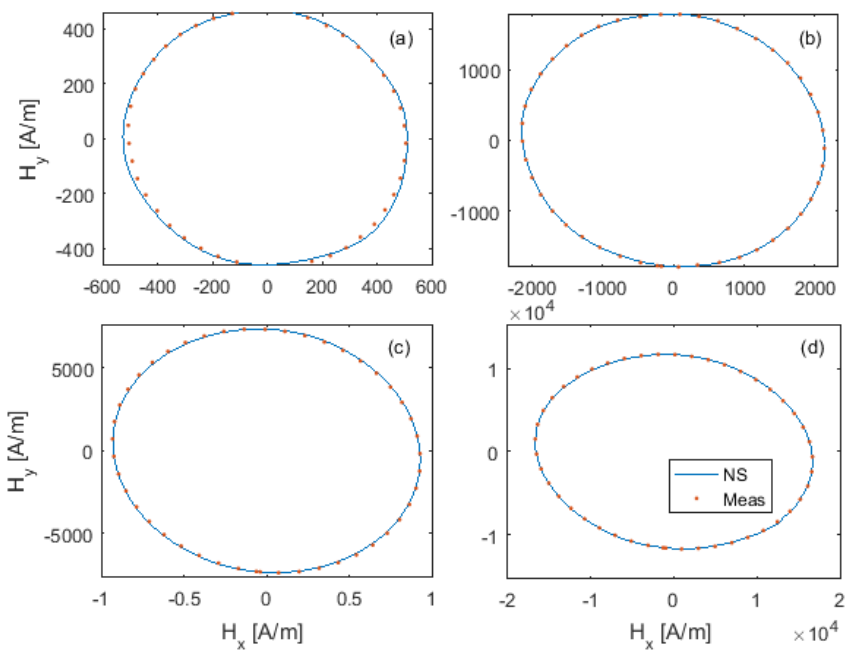
Figure 4. Comparison between the computed (blue solid line) and the measured (red dots) trajecto- ries of H relative to the rotational loops of SET 1, where B = 10 mT ( a ), B = 100 mT ( b ), B = 400 mT ( c ), and B = 600 mT ( d